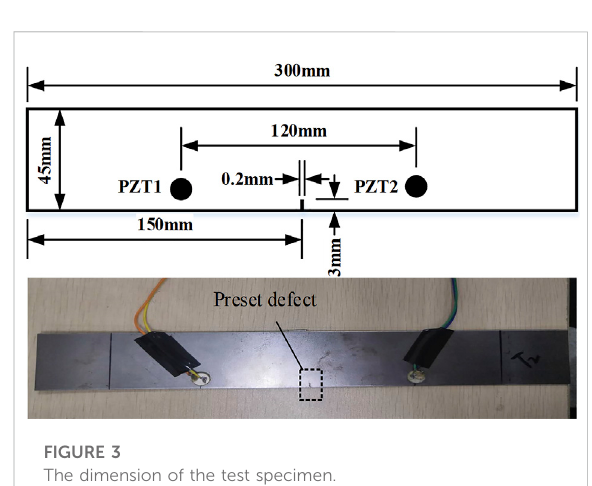
FIGURE 3 The dimension of the test